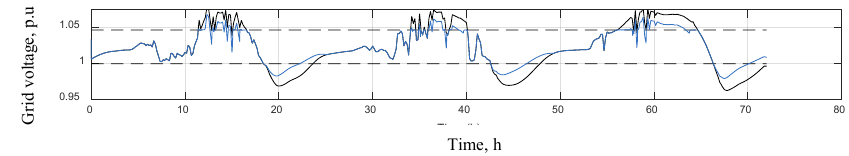
Fig. 5. Voltage mitigation over the hole simulation period by adapting BESS capacity to 9.8 MWh.